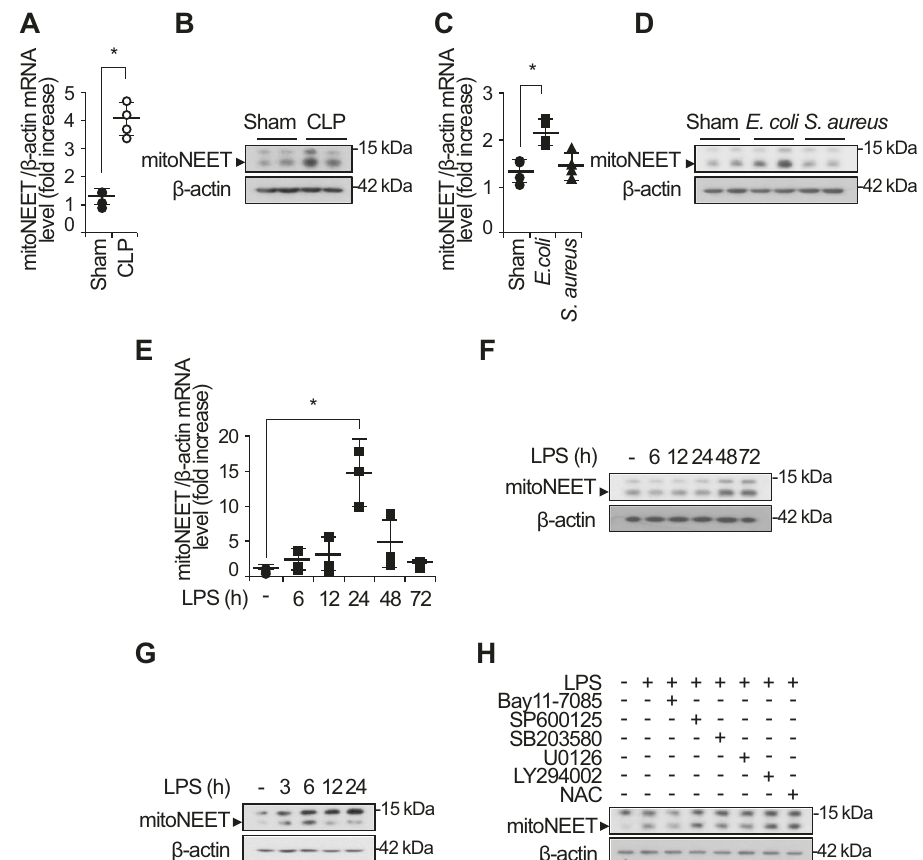
Fig. 1 Expression of mitoNEET mRNA and protein increases during microbial sepsis. Total RNA and protein were extracted from the spleen 48 h after sham or CLP surgery, and fi brin clot-induced microbial sepsis was triggered by E. coli or S. aureus bacteria (1 × 10 8 CFU). Expression of mitoNEET mRNA ( A, C ) and protein ( B, D ) levels was assessed by quantitative real-time RT-PCR or western blotting. *P < 0.05 for sham vs. CLP or fi brin clot-induced microbial sepsis. C57BL/6 mice were injected with LPS (20 mg/kg) or vehicle, and total RNA and protein were extracted from the spleen 6, 12, 24, 48, and 72 h after administration of vehicle or LPS (100 ng/mL). Total protein was extracted from BMDMs 3, 6, 12, and 24 h after administration of vehicle or LPS (100 ng/mL). Expression of mitoNEET mRNA ( E ) and protein ( F, G ) was assessed by quantitative real- time RT-PCR or western blotting. Total protein was extracted from BMDMs 6 h after administration of vehicle or LPS (100 ng/mL) plus a signaling inhibitor (5 µM BAY11-7082, 10 µM SP600125, 10 µM SB203580, 10 µM U0126, 10 µM LY2940002, or 20 mM NAC). Expression of mitoNEET protein was assessed by western blotting ( H ). All data are expressed as the mean ± SD from three independent experiments. *P < 0.05 for vehicle vs. LPS